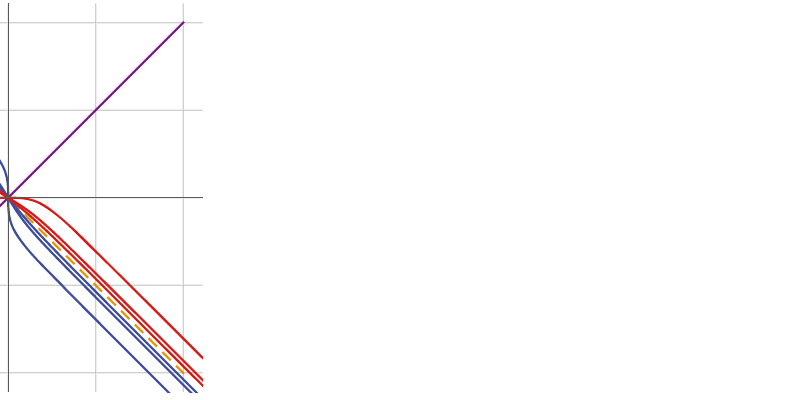
Figure 15: Spacelike ( blue ) and timelike ( red ) elastic curves in (cid:2) 2 with = > σ c 4 0 and = E c 4 2 , = c 1, 2, 3 .